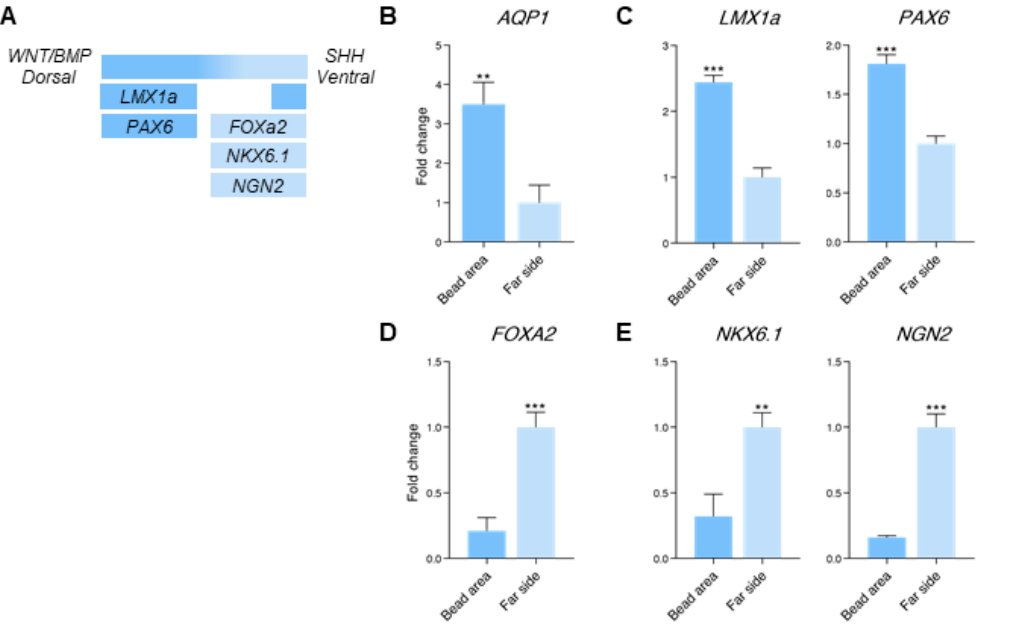
Figure 4. Generation of dorsal and ventral midbrain identities (2 × condition). ( A ) Schematic of gene expression patterning of the dorso-ventral axis in the developing midbrain. ( B – E ) qPCR analysis of genes that are expressed in the bead area versus the far side of the organoid ( B ) AQP1 ; ( C ) LMA1a and PAX6 genes, which are mostly expressed in the dorsal midbrain; ( D ) FOXA2 , a ventral-side marker; ( E ) NKX6.1 and NGN2 , which are expressed in the ventral midbrain and are regulated by FOXA2 . Error bars represent ± SEM. N = 24 organoids per experimental group. Comparisons were analyzed using Student’s t -test: n.s. non-significant p -value > 0.05, * p -value < 0.05, ** p -value < 0.01, *** p -value < 0.001.